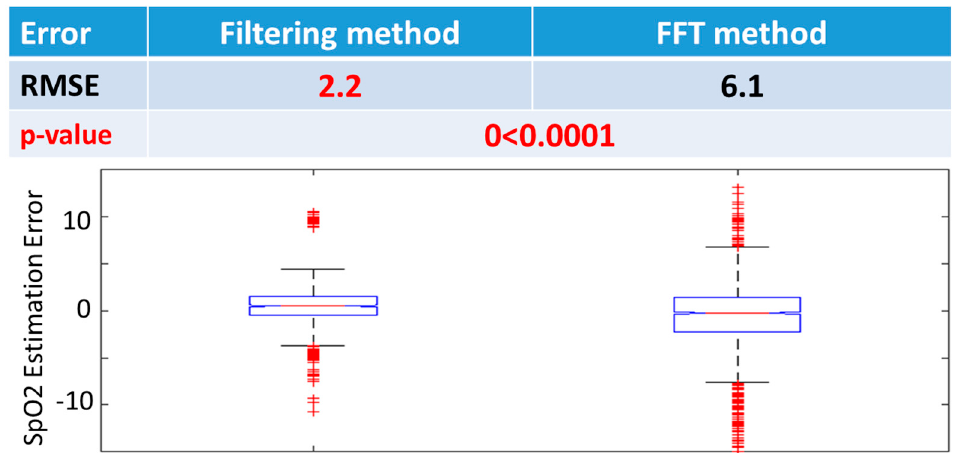
Figure 4. SpO2 model calibration on different parameter calculation methods (filtering method and FFT-based method), showing that the filtering method provides the best performance ( p < 0.0001, sign-rank test). RMSE: Root mean square error (%), FFT: Fast Fourier Transform. Bar graphs represent 10, 25, 50, 75, and 90 percentiles of SpO2 estimation error.